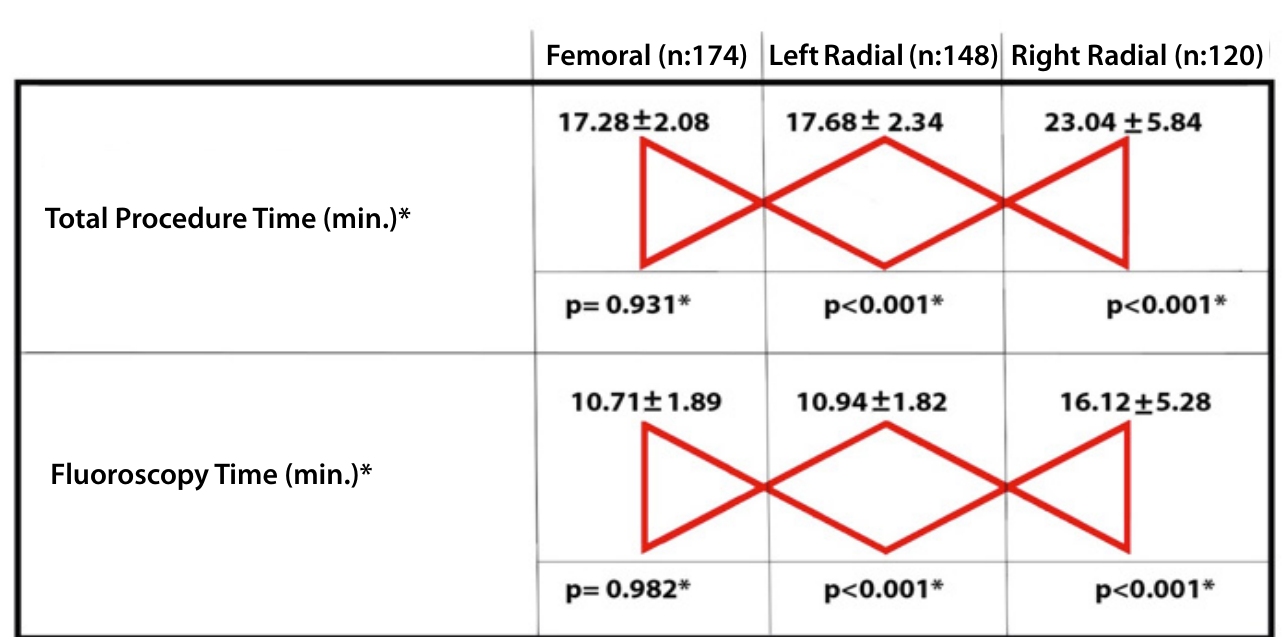
Fig. 3 – Post-hoc analysis of significantly different variables among three groups. *They were analyzed by one way ANOVA Test (95% confidence interval) with Bonferroni method (alpha